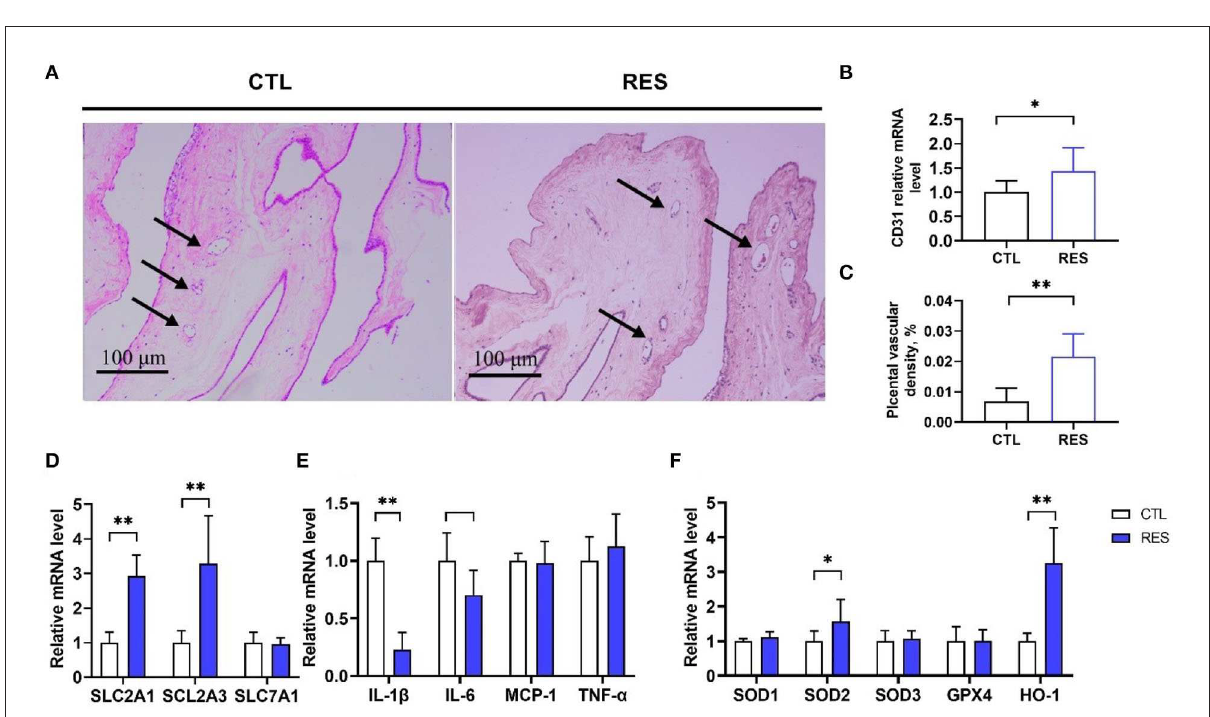
FIGURE4 The effect of RES on vessel density, nutrient transport, antioxidant, and inflammation mRNA expression in the placental. (A,B) The hematoxylin and eosin method was used to examine blood vessel density in placental tissues, and the black arrows indicate placental blood vessels (bar = 100 µ m, n = 12); (C) CD31 mRNA expression; (D) Nutrient transporters SLC2A1 , SCL2A3, and SLC7A1 genes expression; (E) Inflammatory factors IL-1 β , IL-6 , MCP1, and TNF- α genes expression; (F) Antioxidant genes SOD1 , SOD2 , SOD3 , GPX4, and HO-1 expression. CTL, a basal diet; and RES, a basal diet containing 200 mg/kg resveratrol. Data are expressed as mean ± SD ( n = 8); *, p < 0.05; and **, p < 0.01.